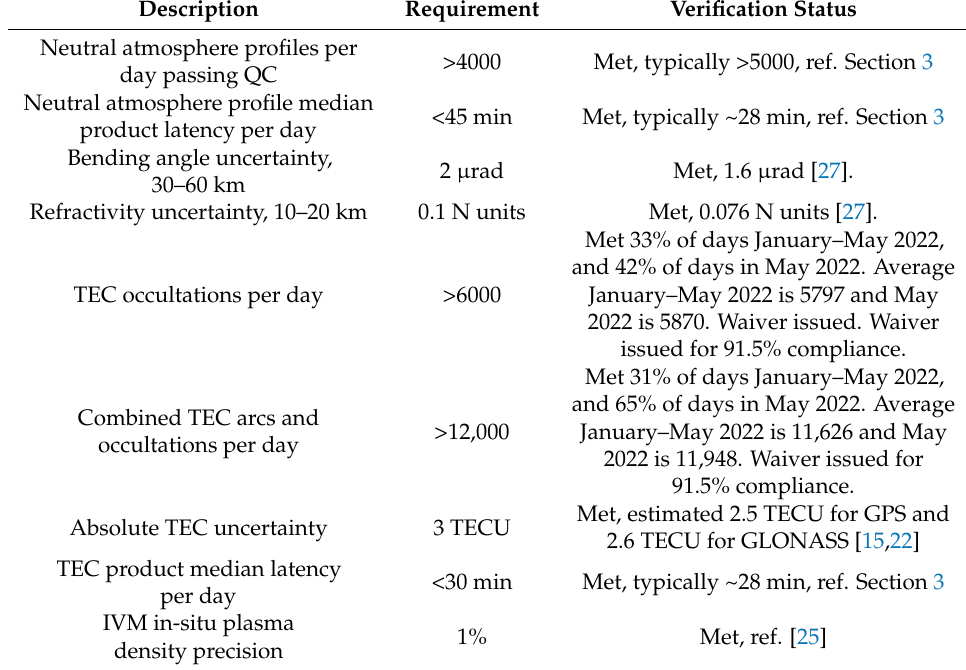
Table 4. Selected level 1 science threshold requirement verification